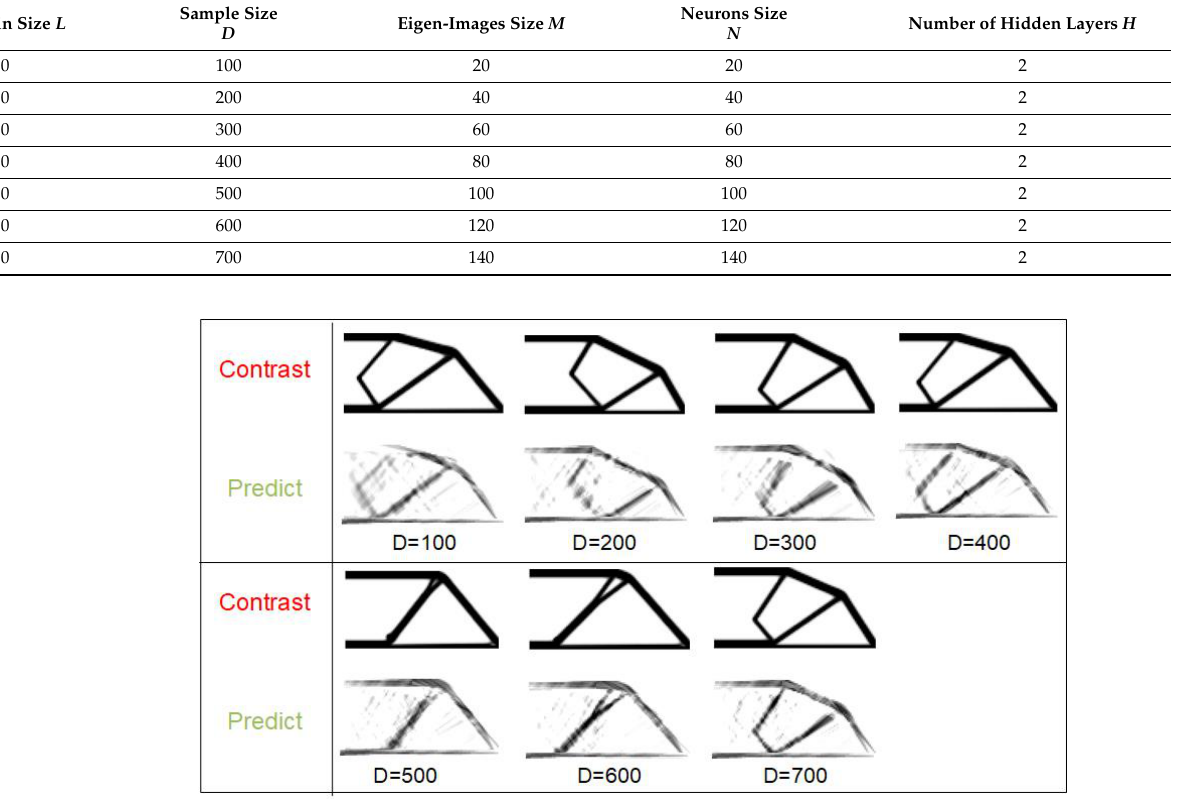
Figure 12. The prediction result after adjusting parameters of training 4 with different D.